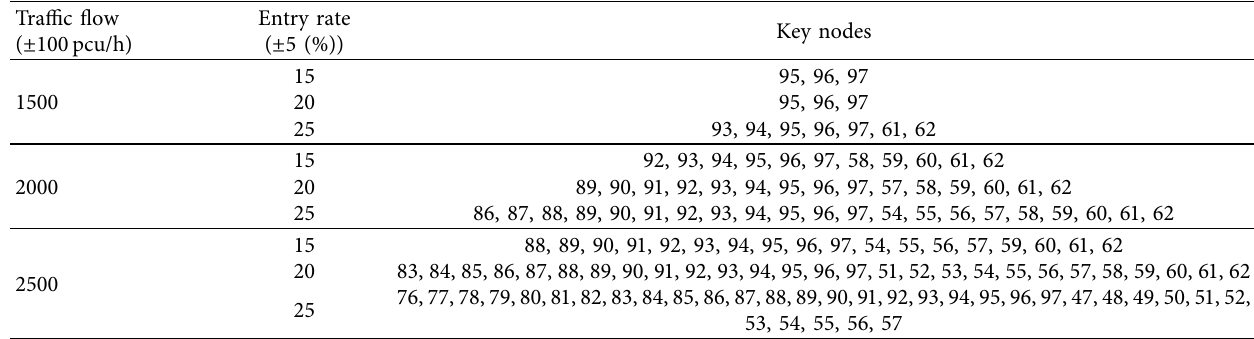
Table 3: Key nodes of congestion